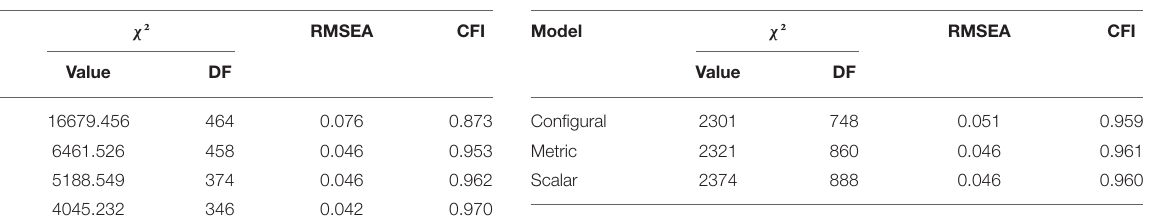
TABLE 3 | χ ² -test and fit indices for invariance